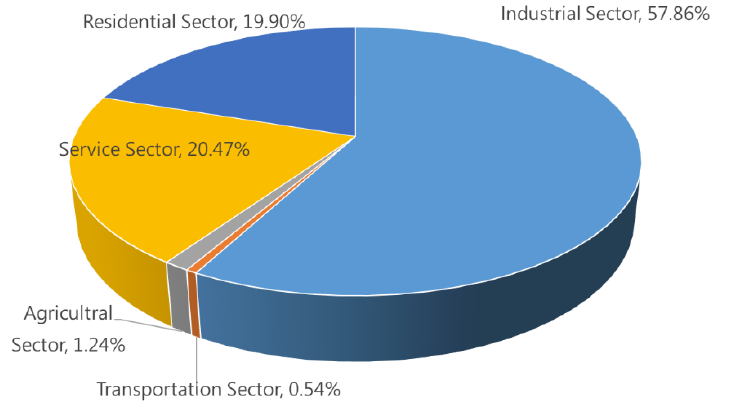
Figure 7. Average electricity demand by sector for 2005 – 2020. Source: Bureau of Energy, MOEA .